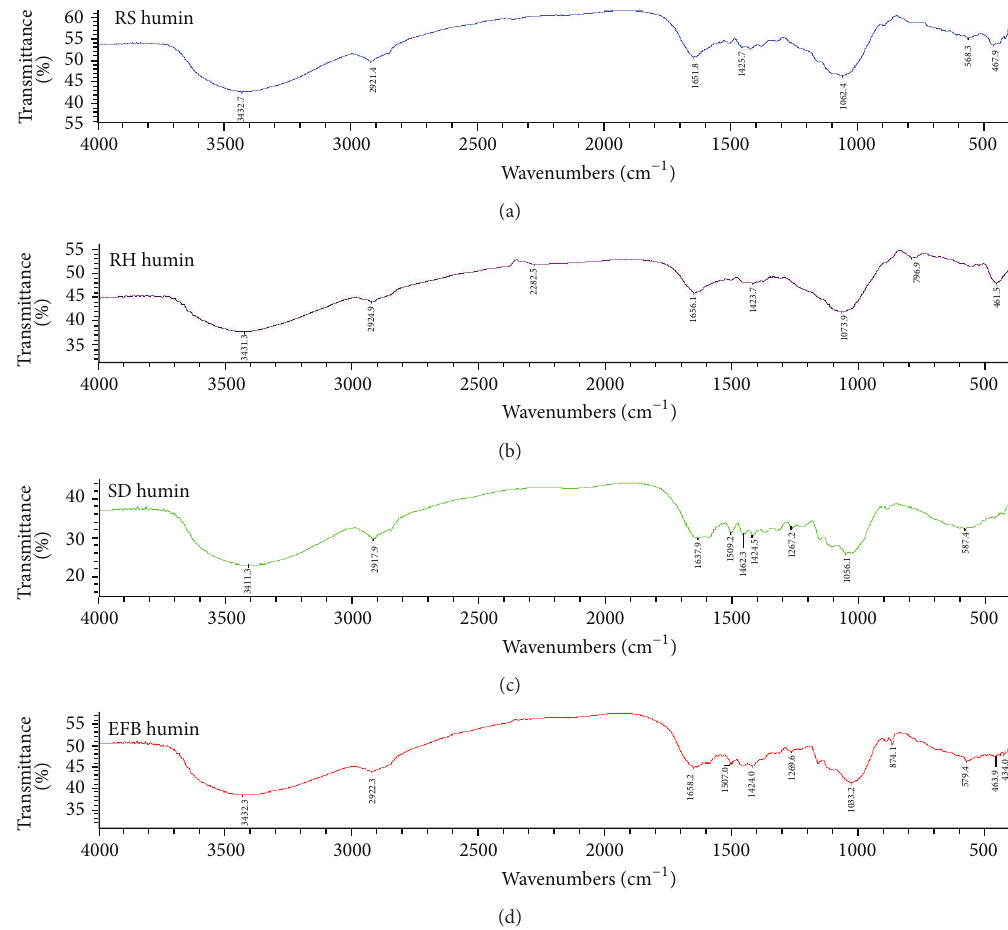
Figure 3: Fourier transform infrared (FTIR) spectra of crude humins from rice straw, rice husk, sawdust, and oil palm empty fruit bunch.